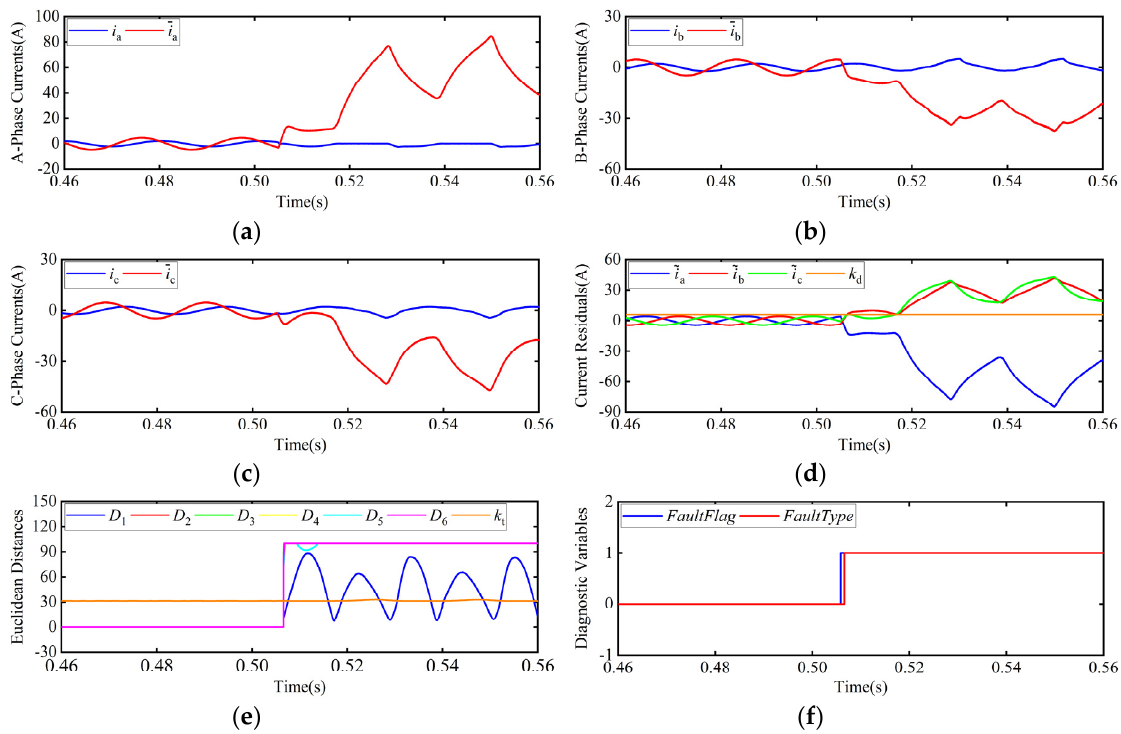
Figure 11. Diagnostic results of 40% parameter deviations: ( a ) A-phase currents; ( b ) B-phase currents; ( c ) C-phase currents; ( d ) current residuals; ( e ) Euclidean distances; ( f ) diagnostic variables.